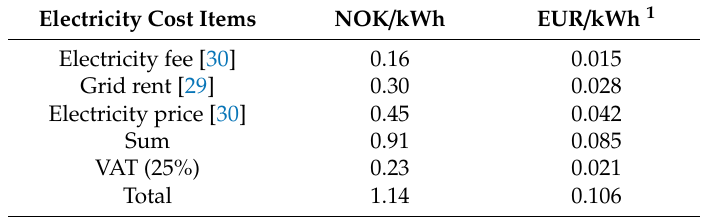
Table 6. Variation of the U-values of the building components from the ZEB-COM design